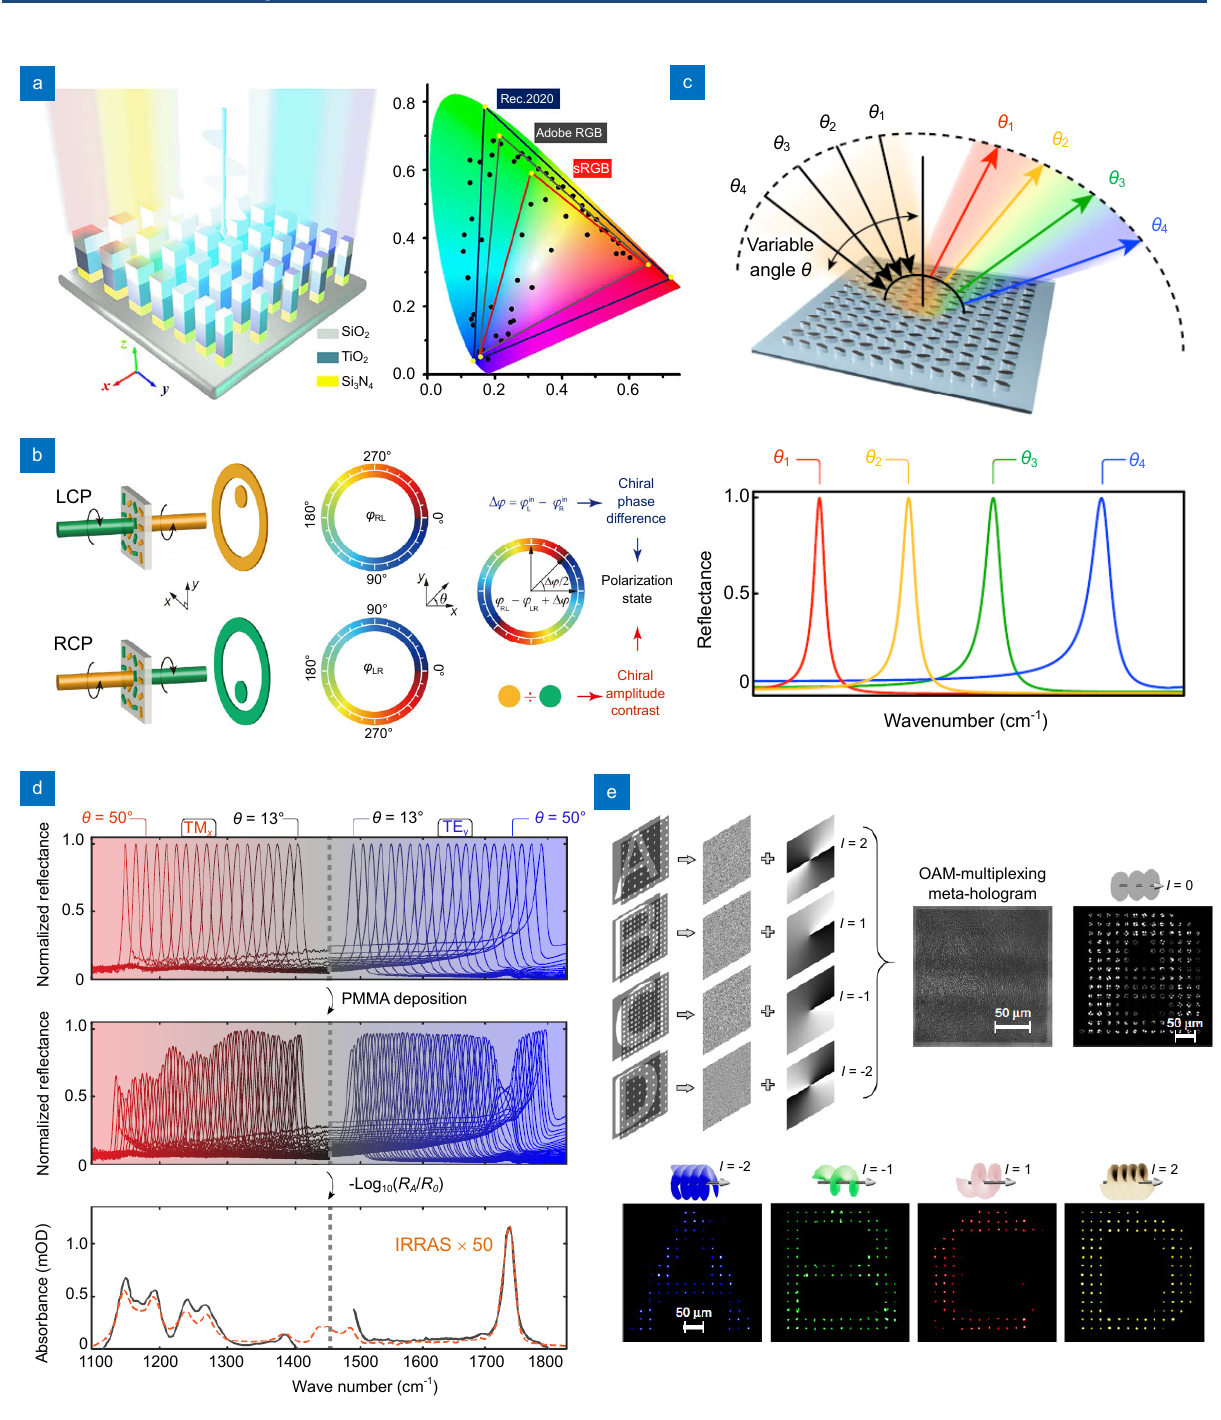
Fig. 8 | ( a ) Left panel: schematic of the metasurface based on multi-dielectric stacked layer structures that can realize ultrahigh saturation structural colors. Right panel: the simulated CIE 1931 chromaticity coordinates for the samples with different periods and gaps. ( b ) Schematic of the multi- plexed hologram metasurface that can realize direct polarization measurement. ( c ) Schematic of the angle-multiplexed all-dielectric metasurface (upper) and the reflection spectra of the metasurface for different incident angles (lower). ( d ) Normalized reflection spectra of the metasurface before (upper) and after (middle) coating a polymethyl methacrylate (PMMA) layer. Lower panel: absorption spectrum obtained from the measured reflection spectra (black line) and absorption spectrum of a PMMA layer on a gold surface obtained from standard infrared reflection absorption spectroscopy measurement (orange dashed line). ( e ) Design approach (upper left) anld experimental characterization (upper right and lower panels) of an OAM-multiplexing hologram metasurface that can encode different holographic images into different OAM channels. Figure repro- duced from: (a) ref. 265 , American Chemical Society; (b) ref. 284 , Optical Society of America; (c–d) ref. 304 , American Association for the Advancement of Science.; (e) ref. 313 , Nature Publishing